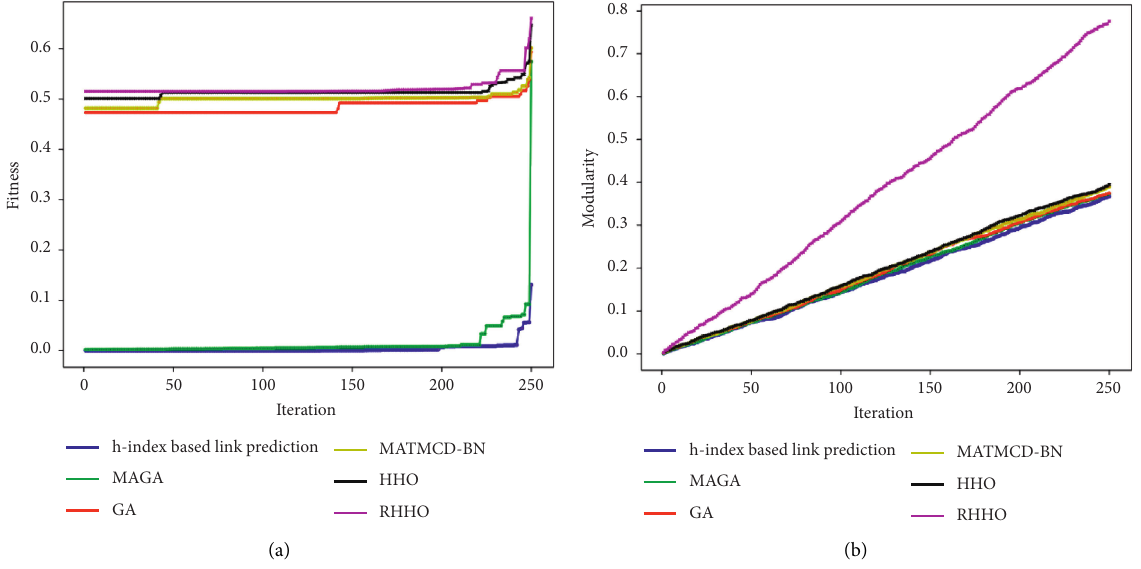
Figure 8: Analysis of methods using the cit-HepPh considering (a) fitness and (b) modularity.